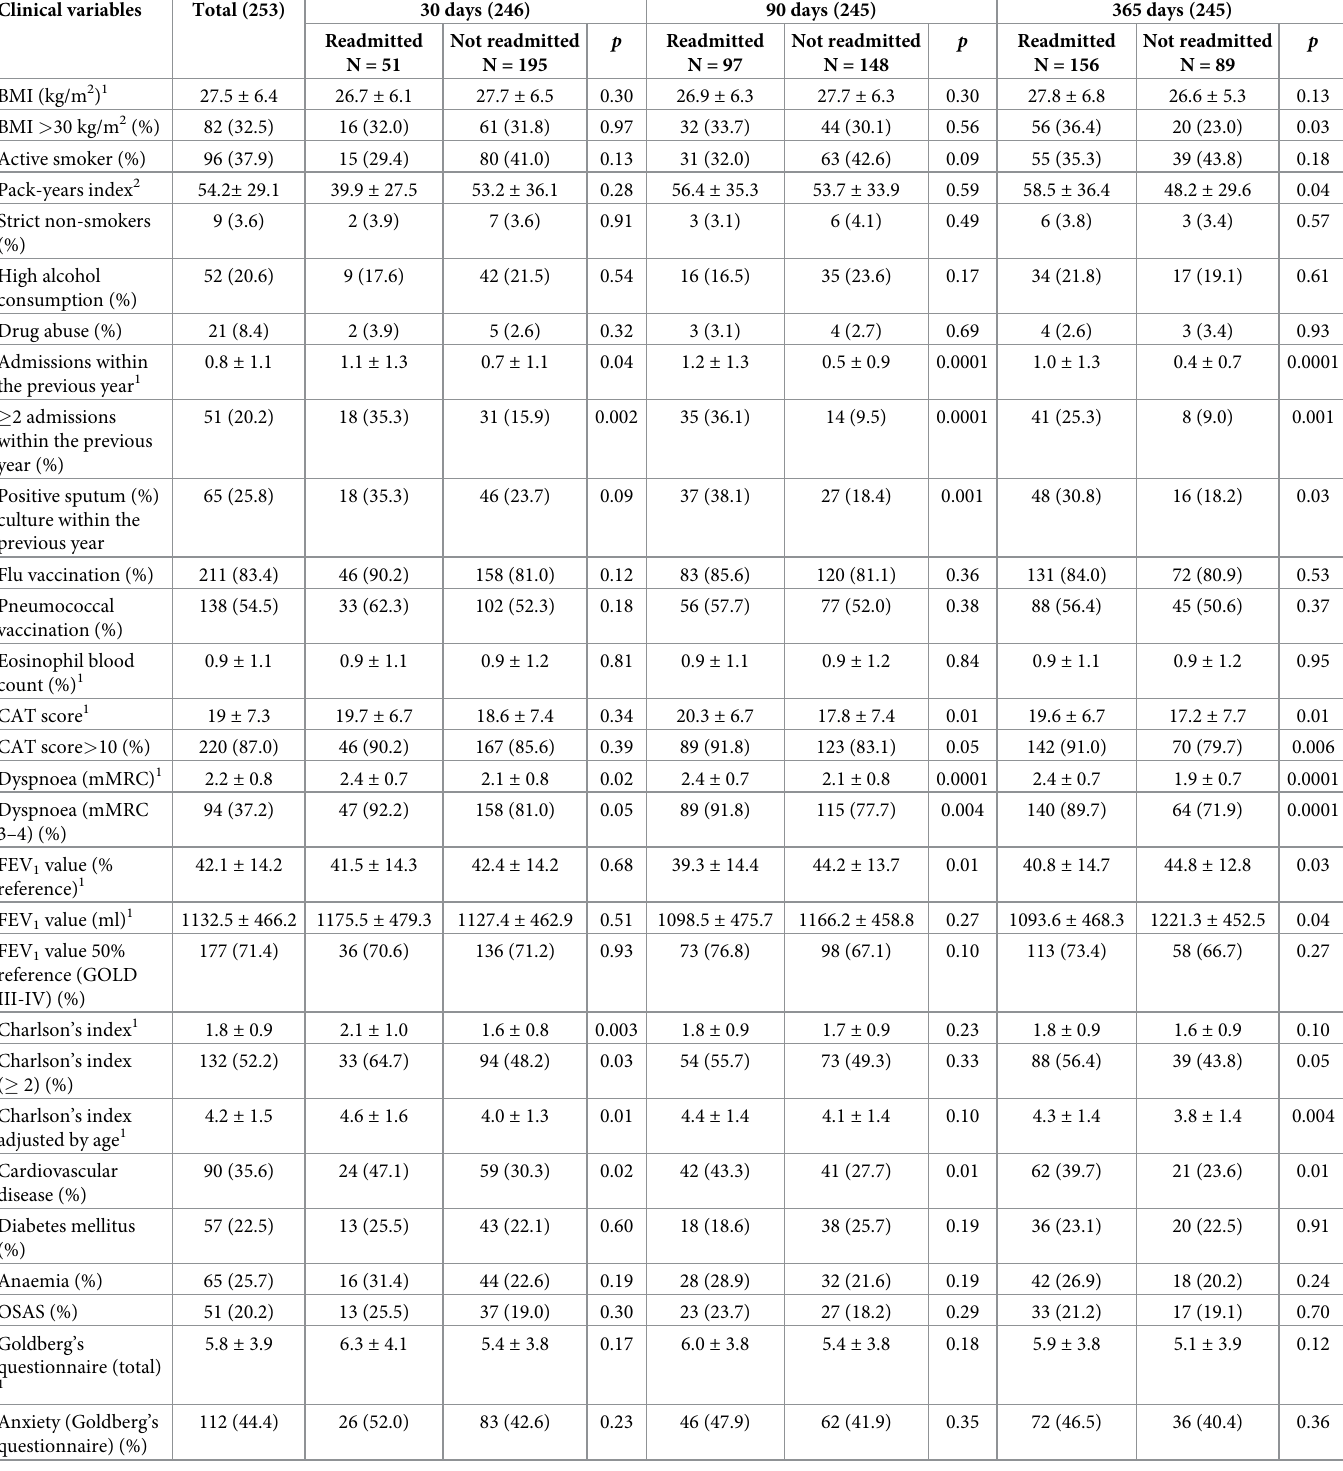
Table 2. Univariate analysis of the demographic and clinical variables with respect to the readmissions at 30, 90, and 365 days. Clinical